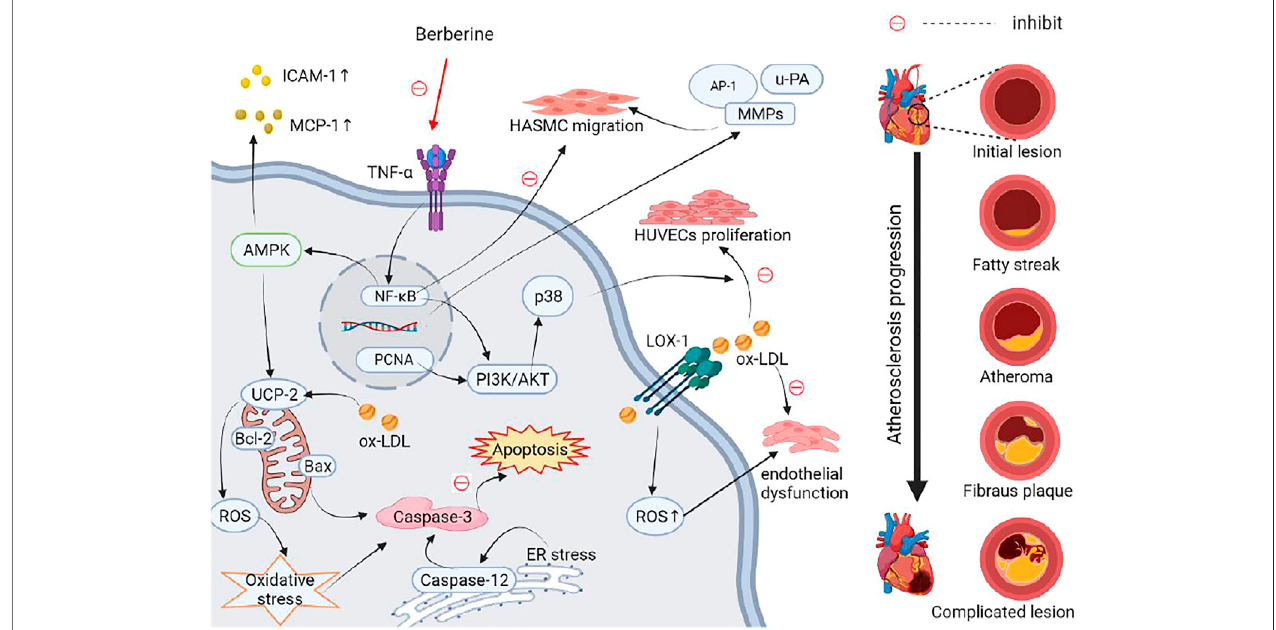
FIGURE 4 | Schematic representation of the possible mechanism of anti-atherosclerosis activity of berberine. The dysregulation of lipid metabolism, vascular endothelial damage can induce abnormal migration of VSMCs, leading to vascular remodeling in atherosclerosis. Increased ox-LDL and LOX-1 cause vascular endothelial dysfunction. In fl ammation leads to excessive expression of ICAM-1 and MCP-1, and aggravation of vascular endothelial proliferation and migration via up- regulating NF- κ B and AMPK pathways. In fl ammation, oxidative stress, and ER stress aggravate vascular endothelial cell apoptosis in atherosclerosis. These adverse effects on atherosclerosis can be reversed by berberine. Abbreviations: Akt, protein kinase B; AMPK, AMP-activated protein kinase; AP-1, activator protein 1; Bax, Bcl-2 associated X protein; Bcl-2, B-cell lymphoma 2; ER, endoplasmic reticulum; HASMC, human aortic smooth muscle cell; ICAM-1, intercellular adhesion molecule 1; LOX-1, low-density lipoprotein receptor 1; MAPK, mitogen-activated protein kinase; MCP-1, monocyte chemoattractant protein 1; MMPs, matrix metalloproteases;NF- κ B,nuclearfactor κ B;Ox-LDL,oxidizedlowdensitylipoprotein;PCNA,proliferatingcellnuclearantigen;PI3K,phosphatidylinositol3-kinase;ROS, reactive oxygen species; TNF- α , tumor necrosis factor α ; UCP-2, uncoupling protein 2; u-PA, urokinase-type plasminogen activator. TABLE 3 | Pharmacological properties of berberine in the treatment of cerebrovascular disease. Model Doses/Duration